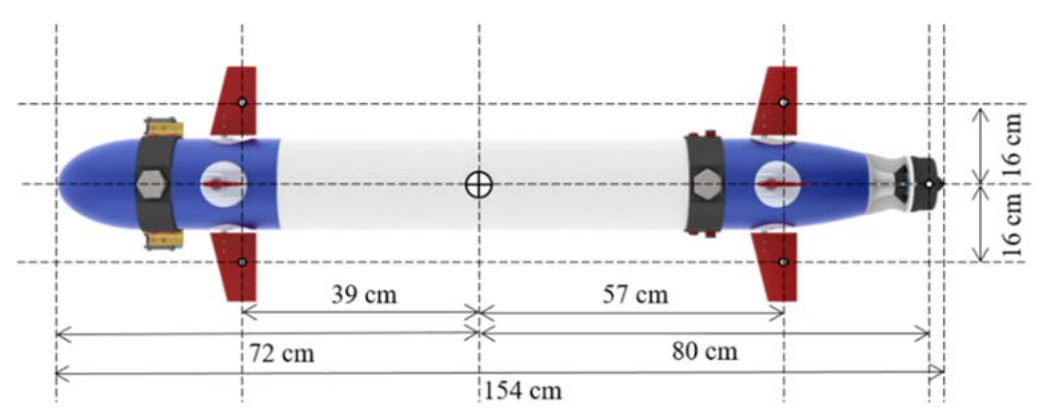
Figure 6. Top view of the developed torpedo-like underwater vehicle.